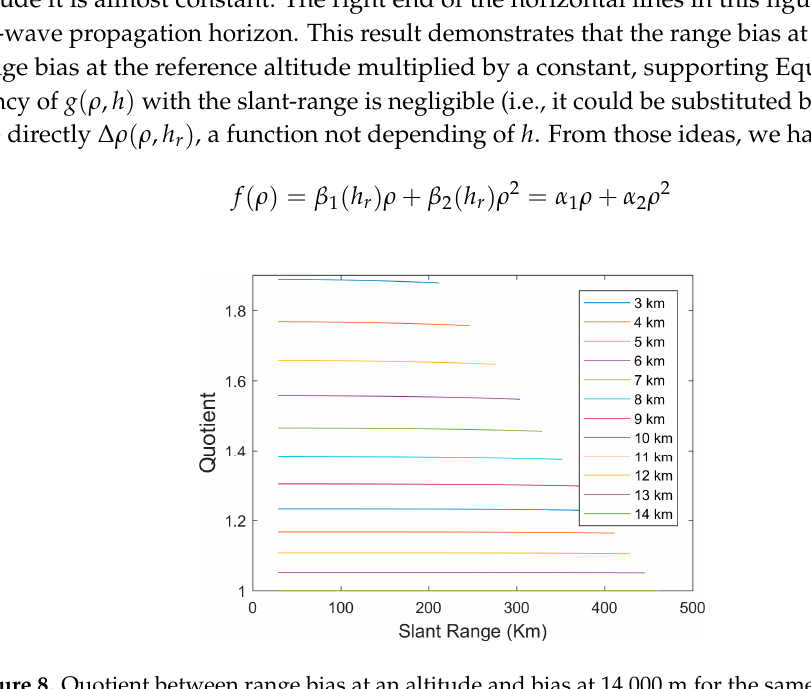
Figure 8. Quotient between range bias at an altitude and bias at 14000 m for the same slant range.